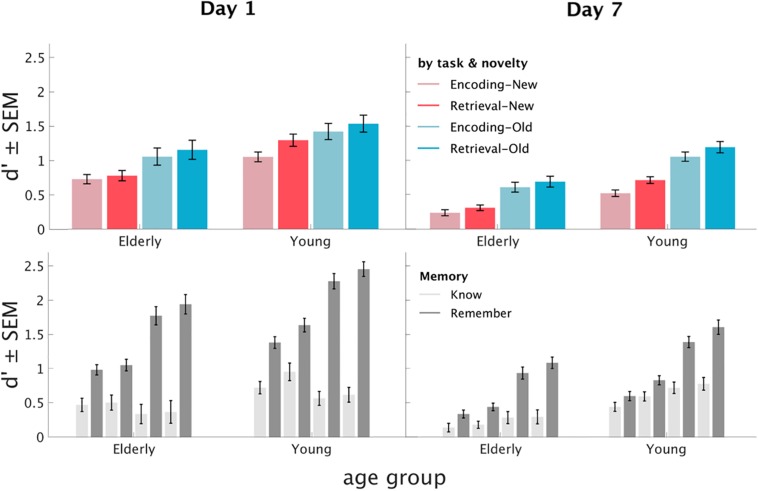
Memory performance for Day 1 and Day 7. D′ values for all conditions: Day (separate plots), Age group (x-axis), Memory (lightness), Task (color saturation), stimulus Novelty (color temperature, blue = old).